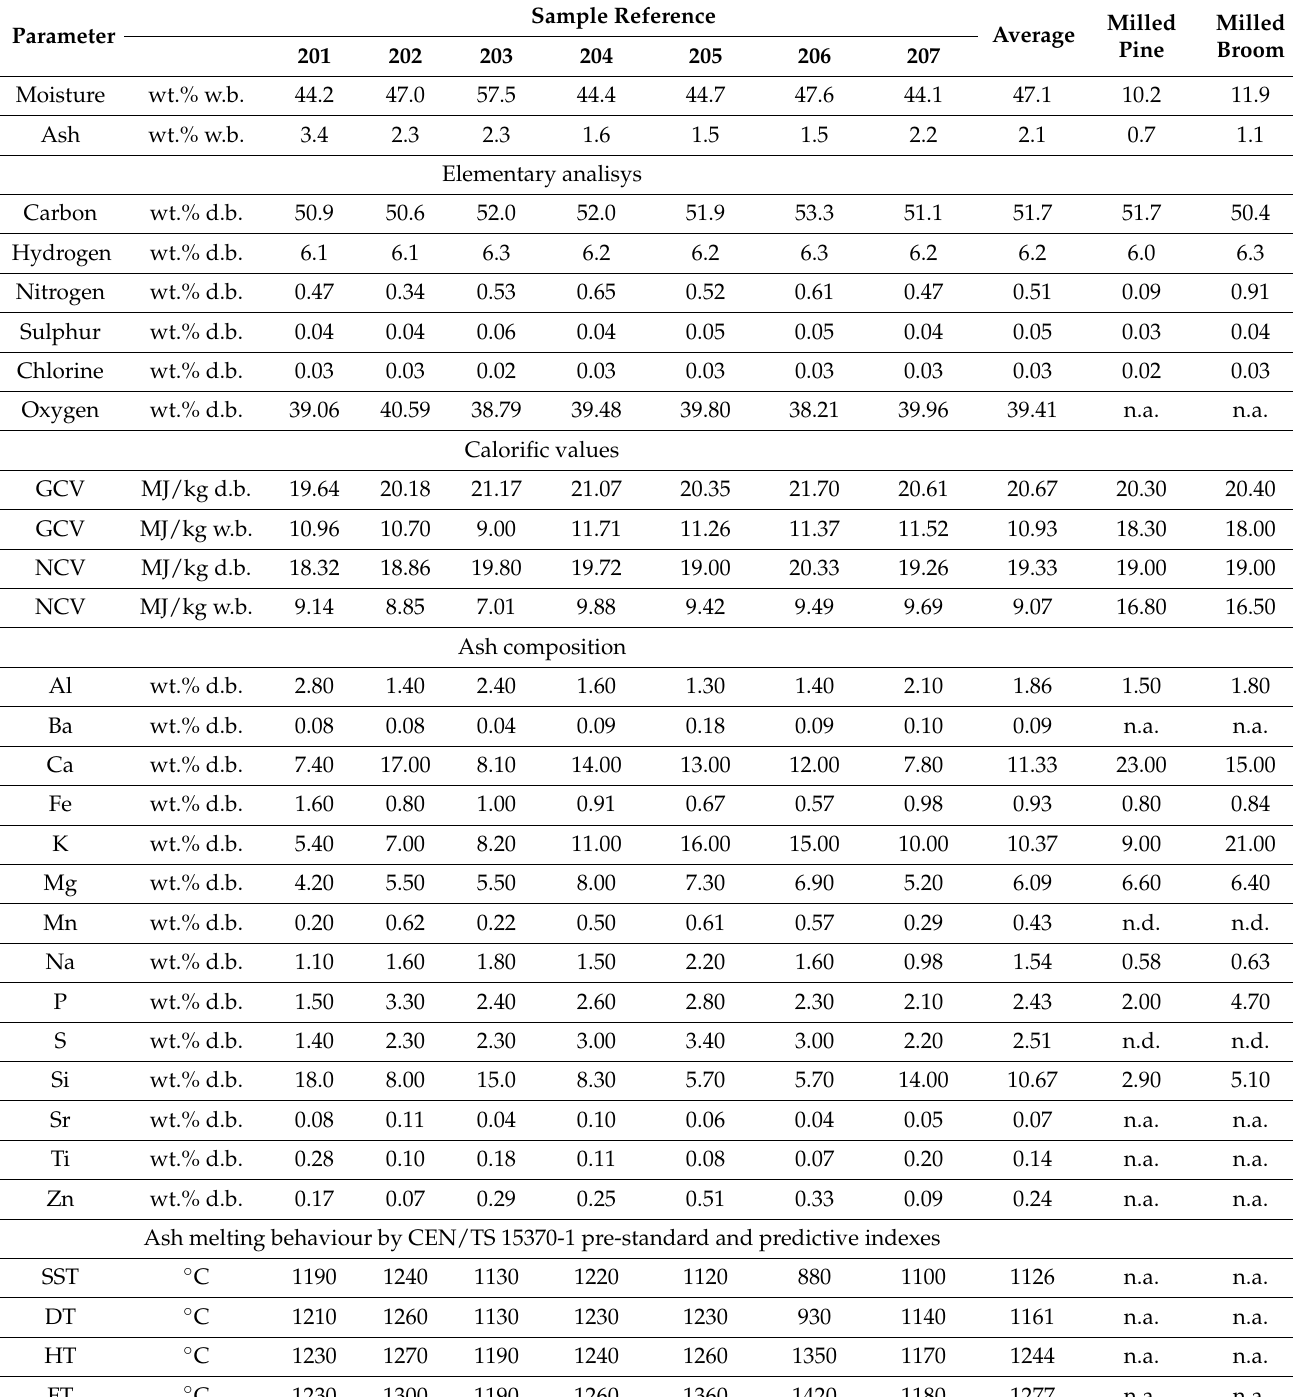
Table 7. Bale biomass physical and chemical properties. Acronyms: GCV, gross calorific value; NCV, net calorific value; wt.%, weight%; w.b., wet basis; WM, wet matter; d.b., dry basis; n.a., not available; SST, shrinkage staring temperature; DT, deformation temperature; HT, hemisphere temperature; FT, flow temperature.